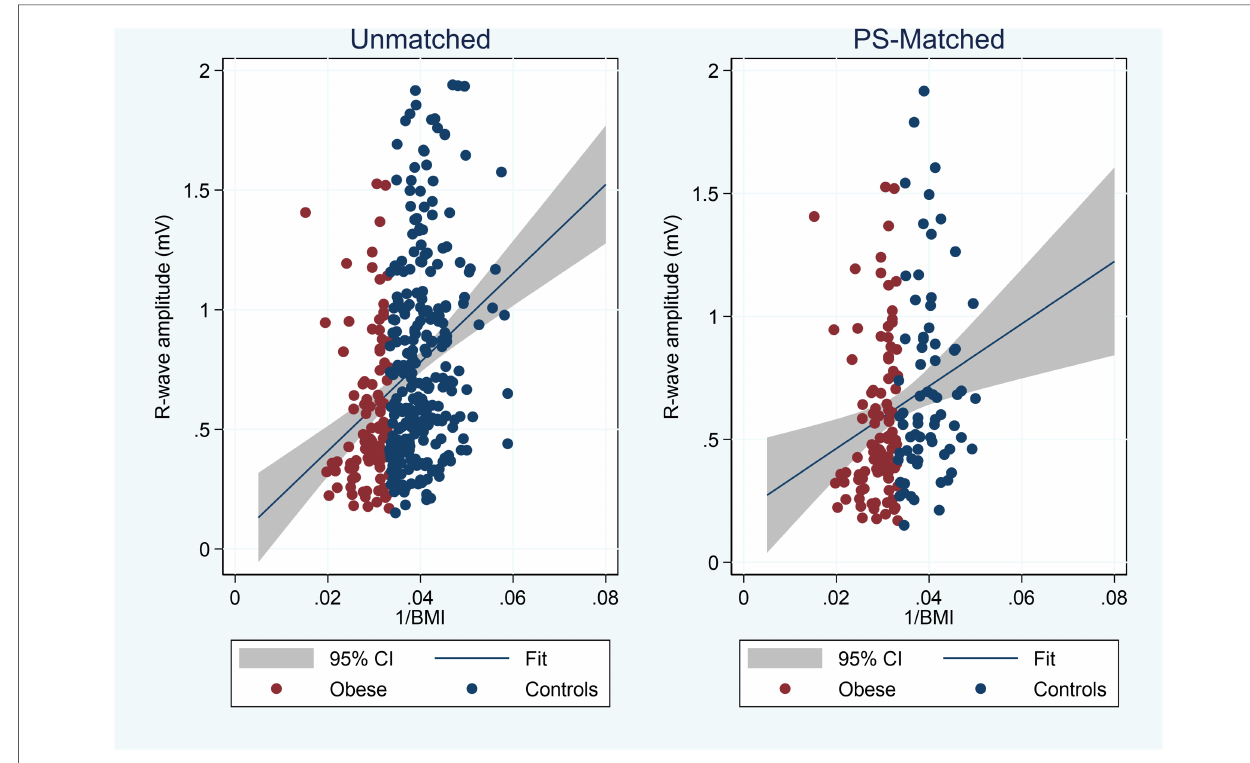
FIGURE 2 Plot of average 3-month R-wave amplitudes vs. inverse BMI values and linear fi t (blue line) with 95% con fi dence interval (CI) in unmatched and propensity score (PS) matched cohorts.